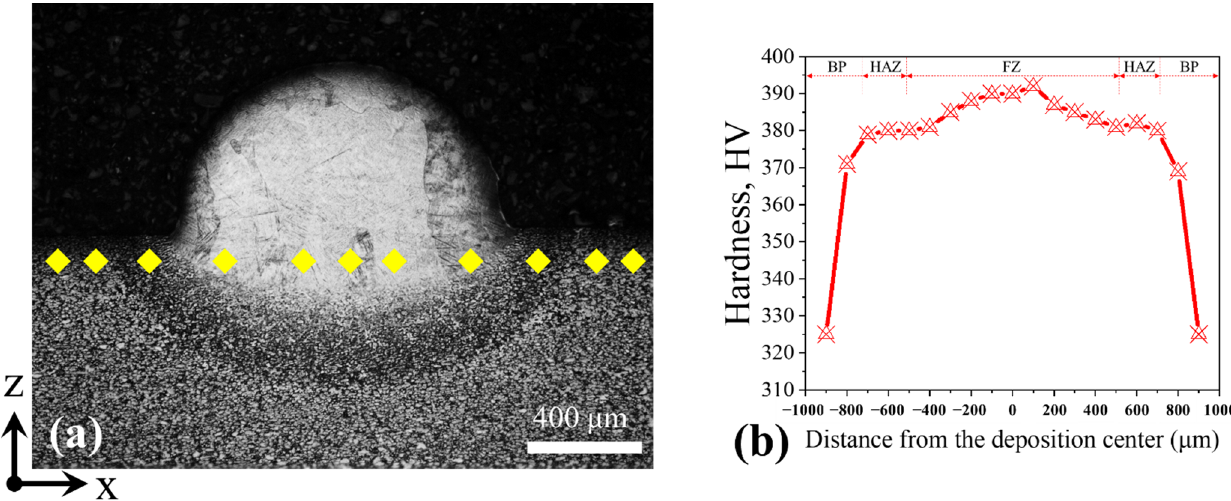
Figure 7. ( a ) Measured hardness locations in the as-fabricated sample. ( b ) Variation in the hardness of the DED-processed Ti–6Al–4V component with respect to the distance from the deposition center.